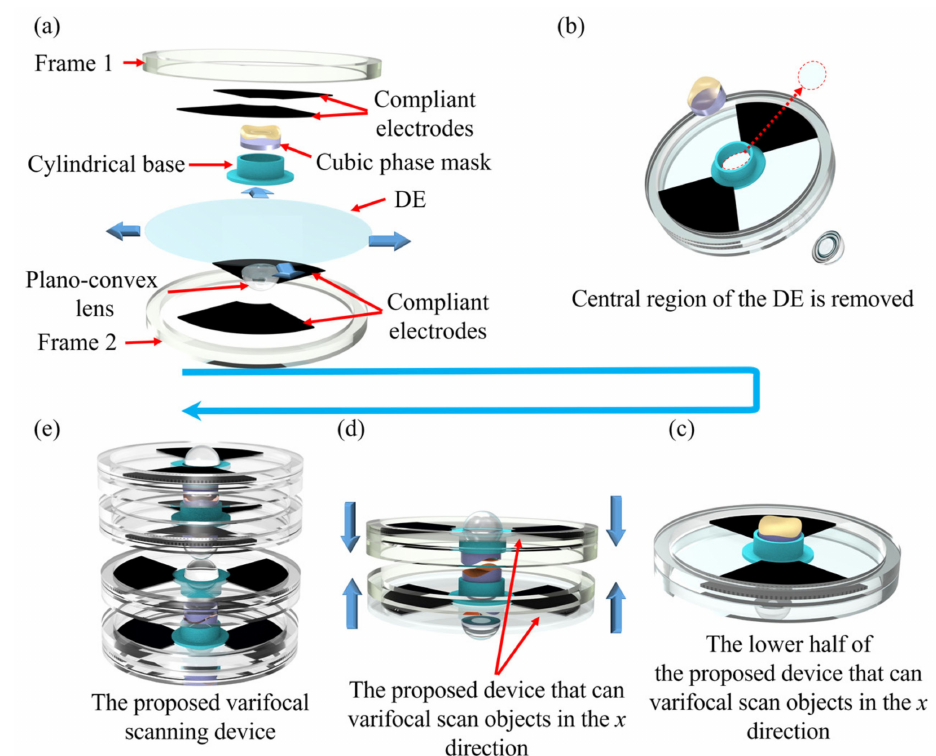
Figure 3. Schematic illustration of the fabrication procedure of the proposed varifocal elements. ( a ) The main components of the varifocal scanning device. The DE (VHB4905, 3M company) is pre-stretched with a ratio of 200%. The top and bottom sides of two local areas of the DE along the x -axis are coated with carbon powder (BP2000, Carbot) as compliant electrodes. ( b ) The central region of the DE is removed and replaced by the cylindrical base. ( c ) The lower half of the proposed device can varifocal-scan objects in the x direction. ( d ) The proposed device can varifocal-scan objects in the x direction. The upper part is the same as the lower part and it is rotated 180 ◦ . ( e ) Assembled varifocal scanning